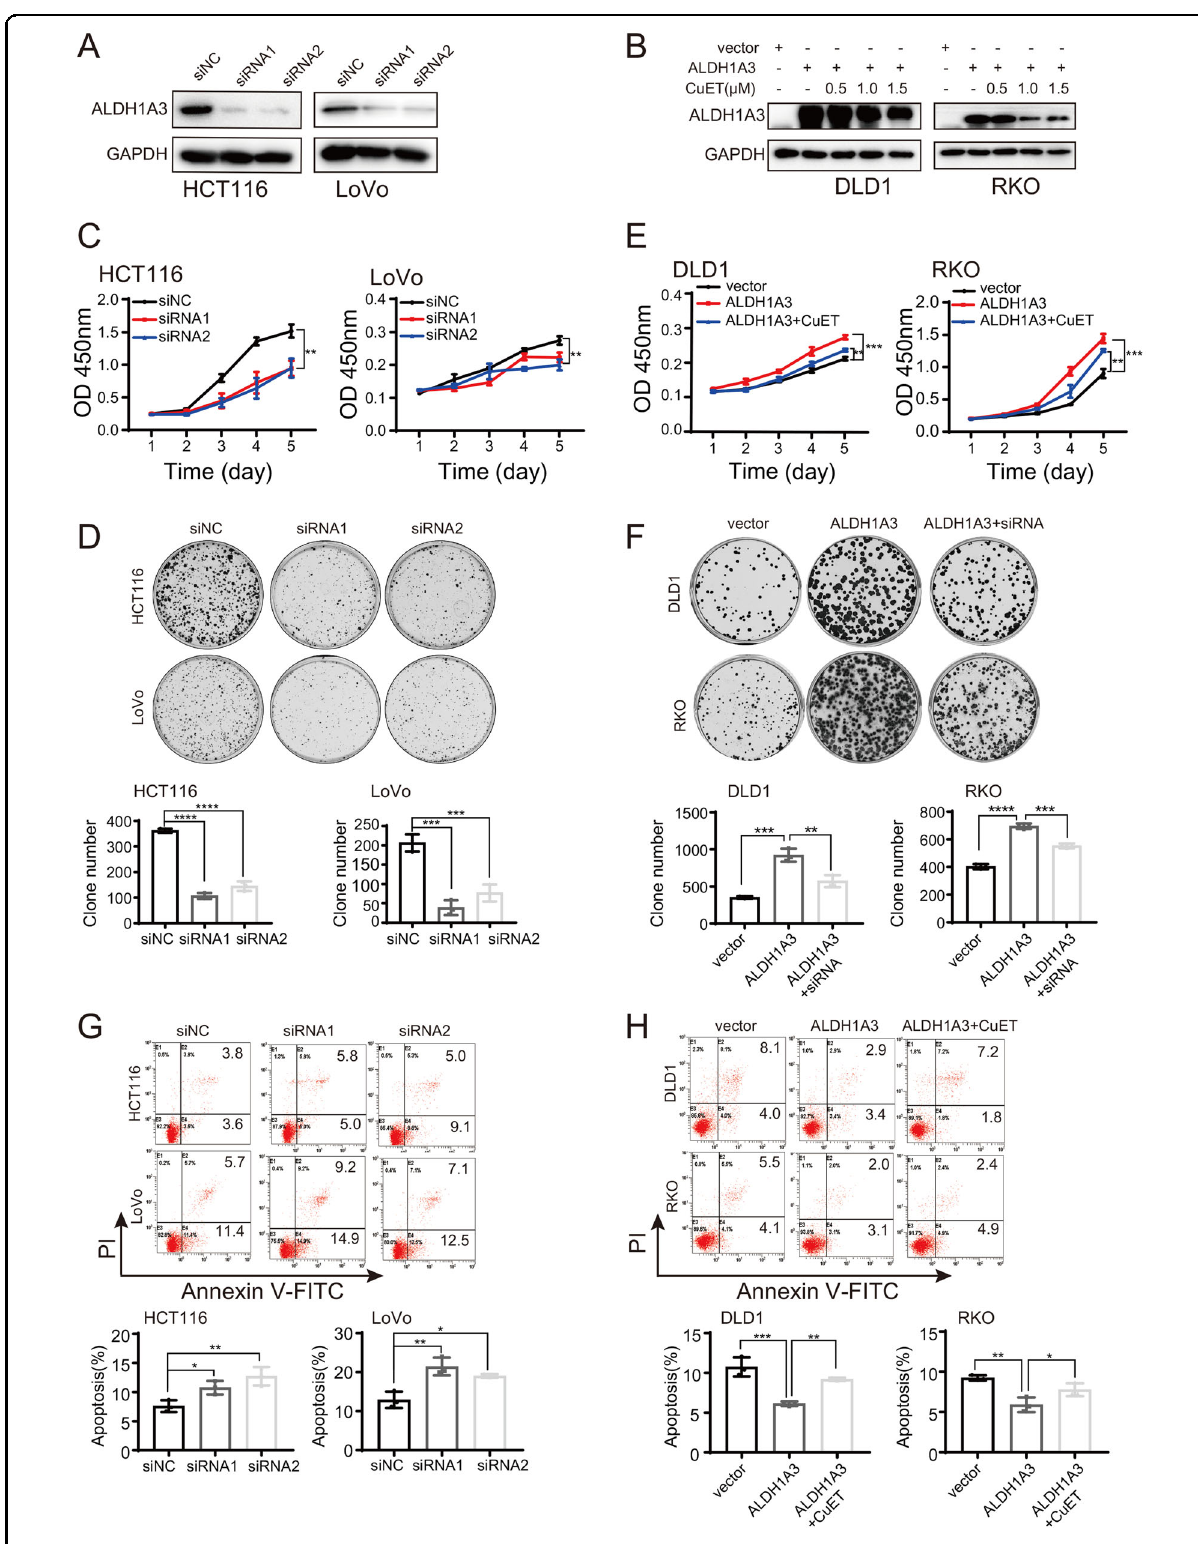
Fig. 4 (See legend on next